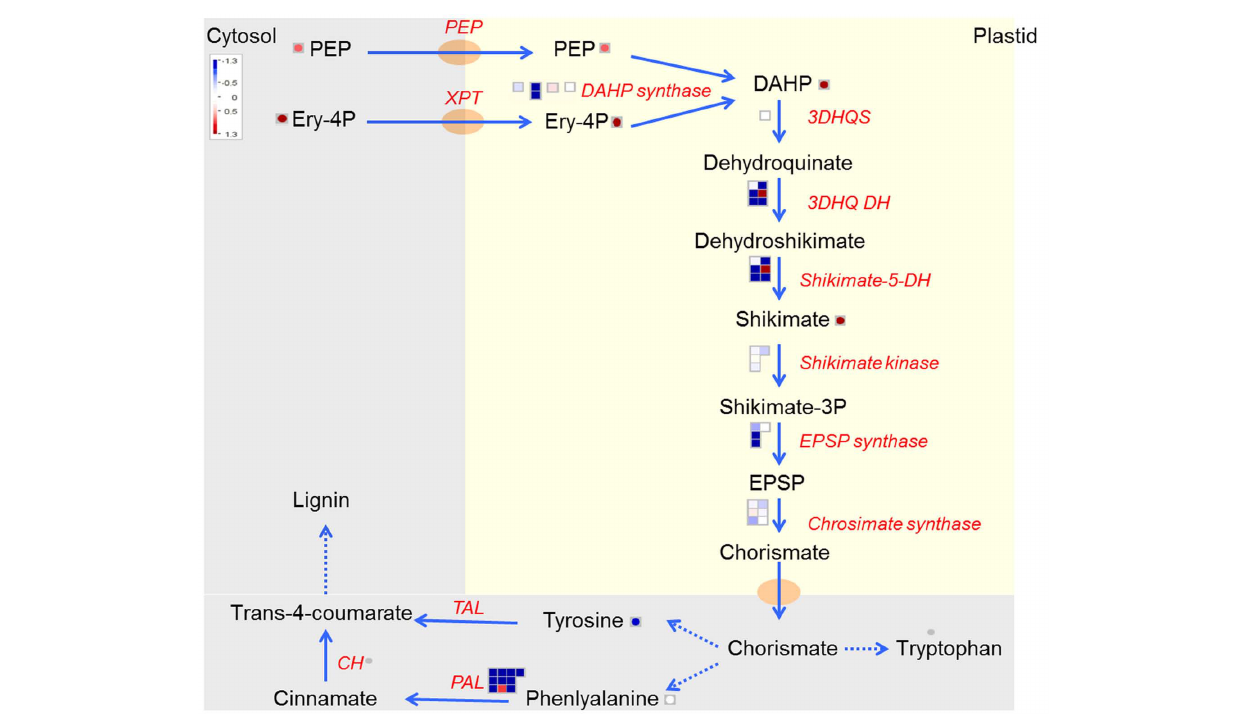
FIGURE 10 | Shikimate biosynthetic pathway producing aromatic amino acids and precursors for lignin in U-IN-2.